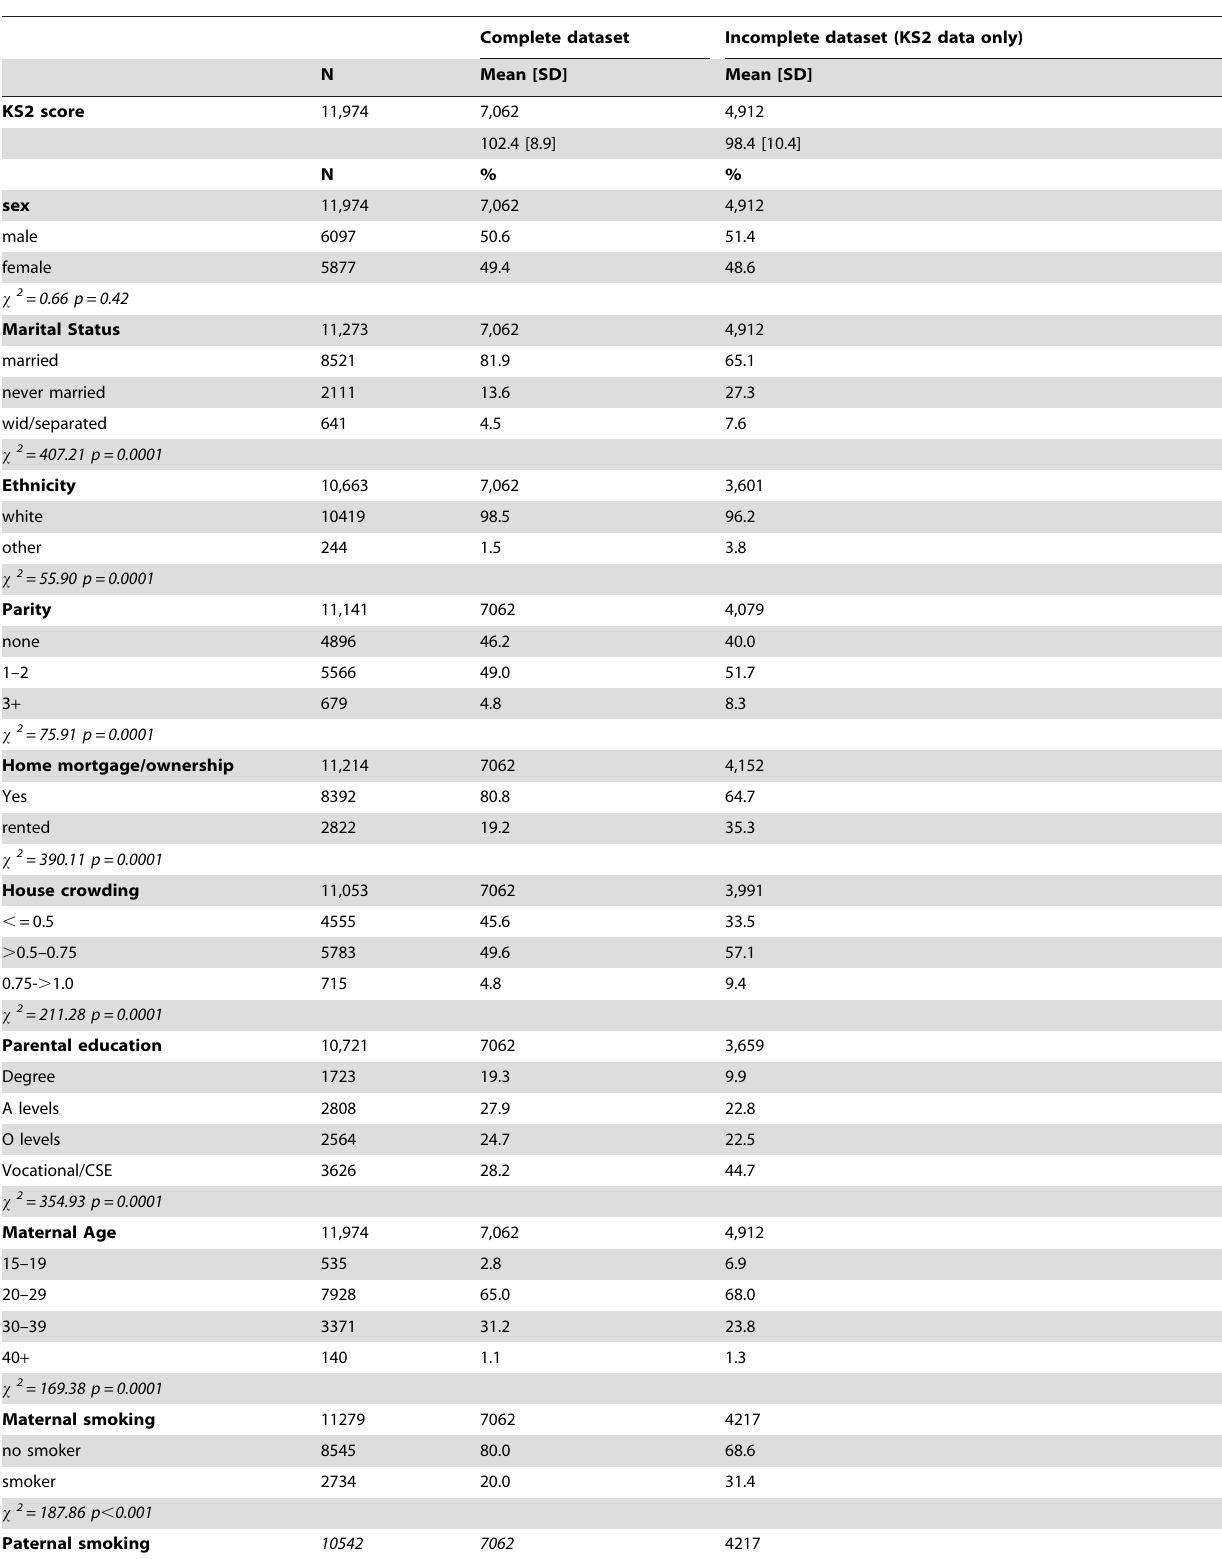
Table 1. Comparisons between those with complete data and those with KS2 data but incomplete data on demographic and other